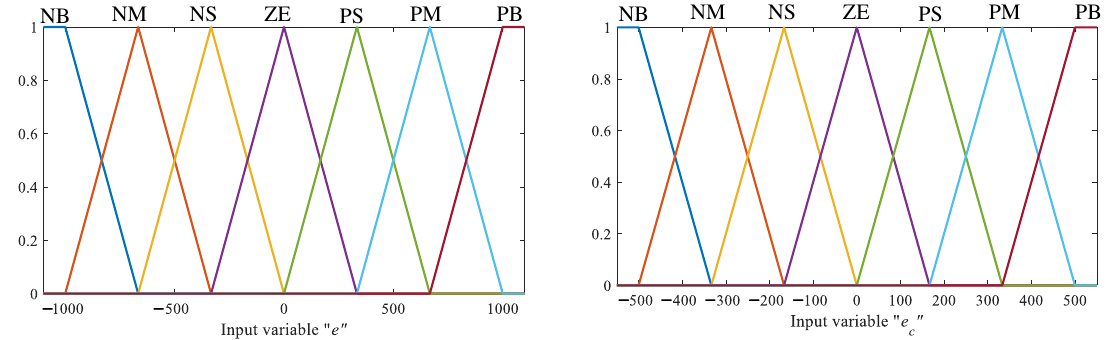
Figure 3. Membership function of input variables e and e c